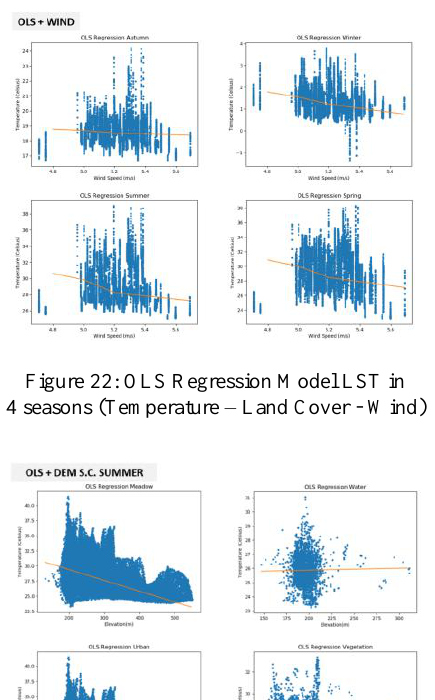
Figure 21: OLS Regression Model LST in 4 seasons (Temperature – Land Cover - DEM)